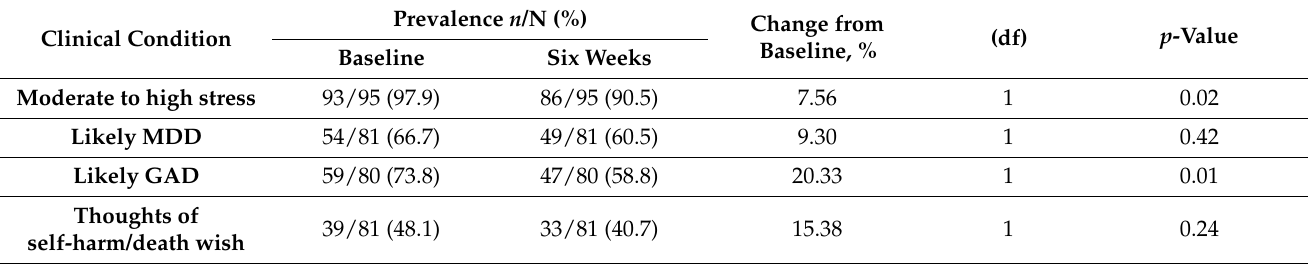
Table 2. Changes in the prevalence of moderate to high stress, likely GAD, and likely MDD.